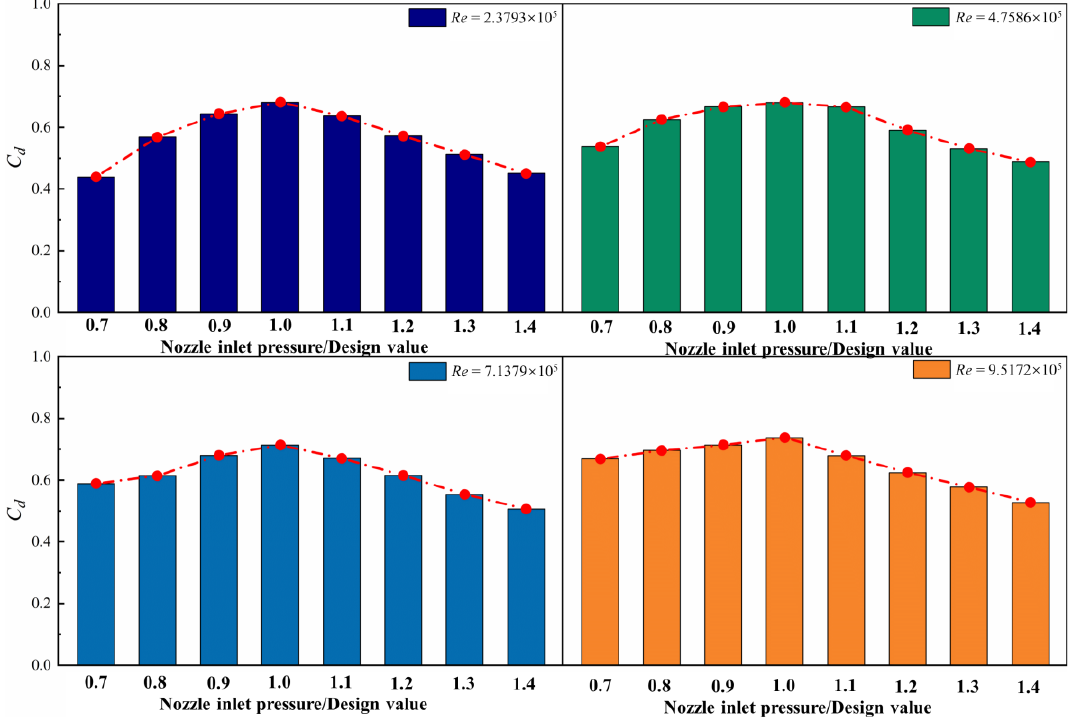
Figure 14. Distribution of 𝐶 𝑑 for receiving hole at different Re .